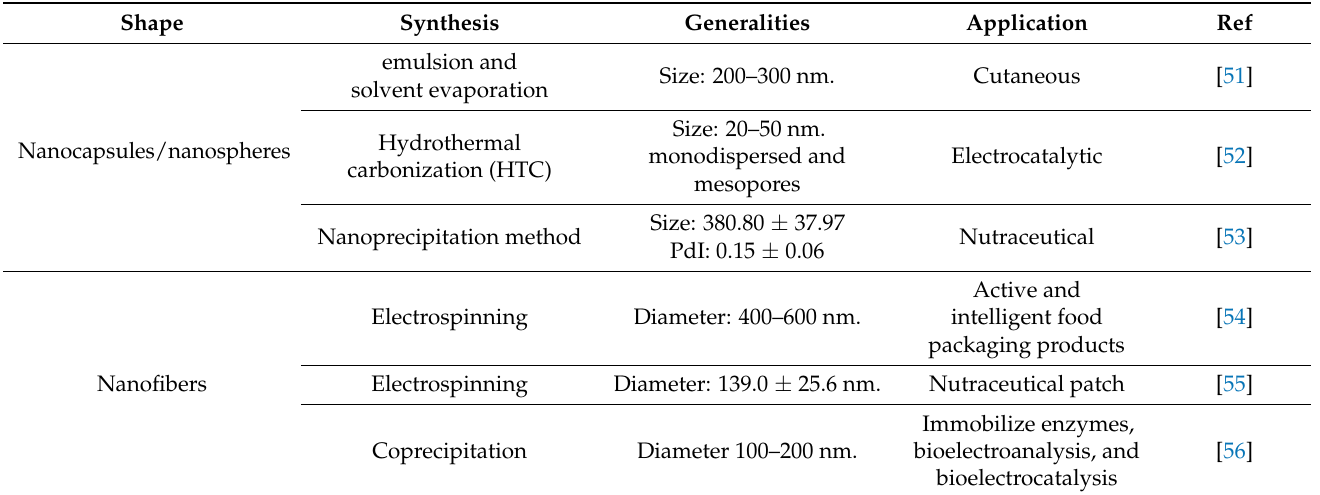
Table 3. Shape and size associated with